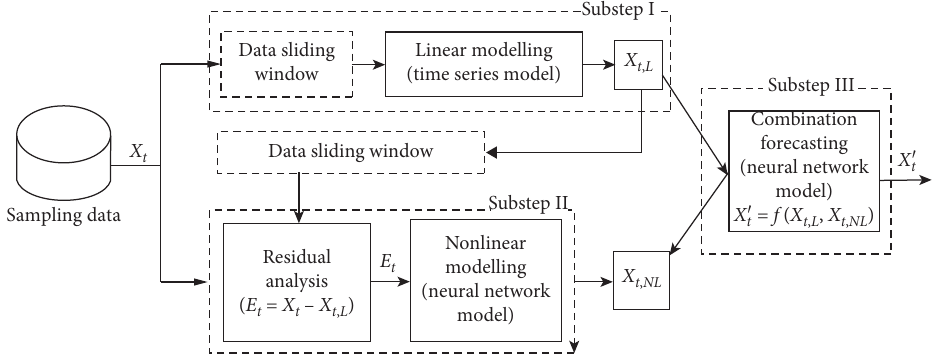
Figure 4: The time series data modelling in the first step.